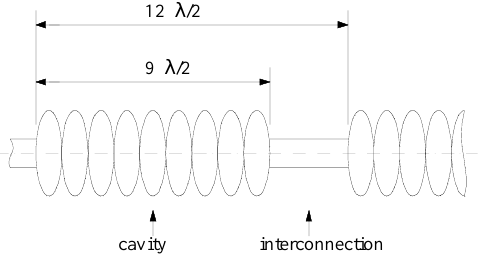
FIG. 1. The 9-cell cavity and the